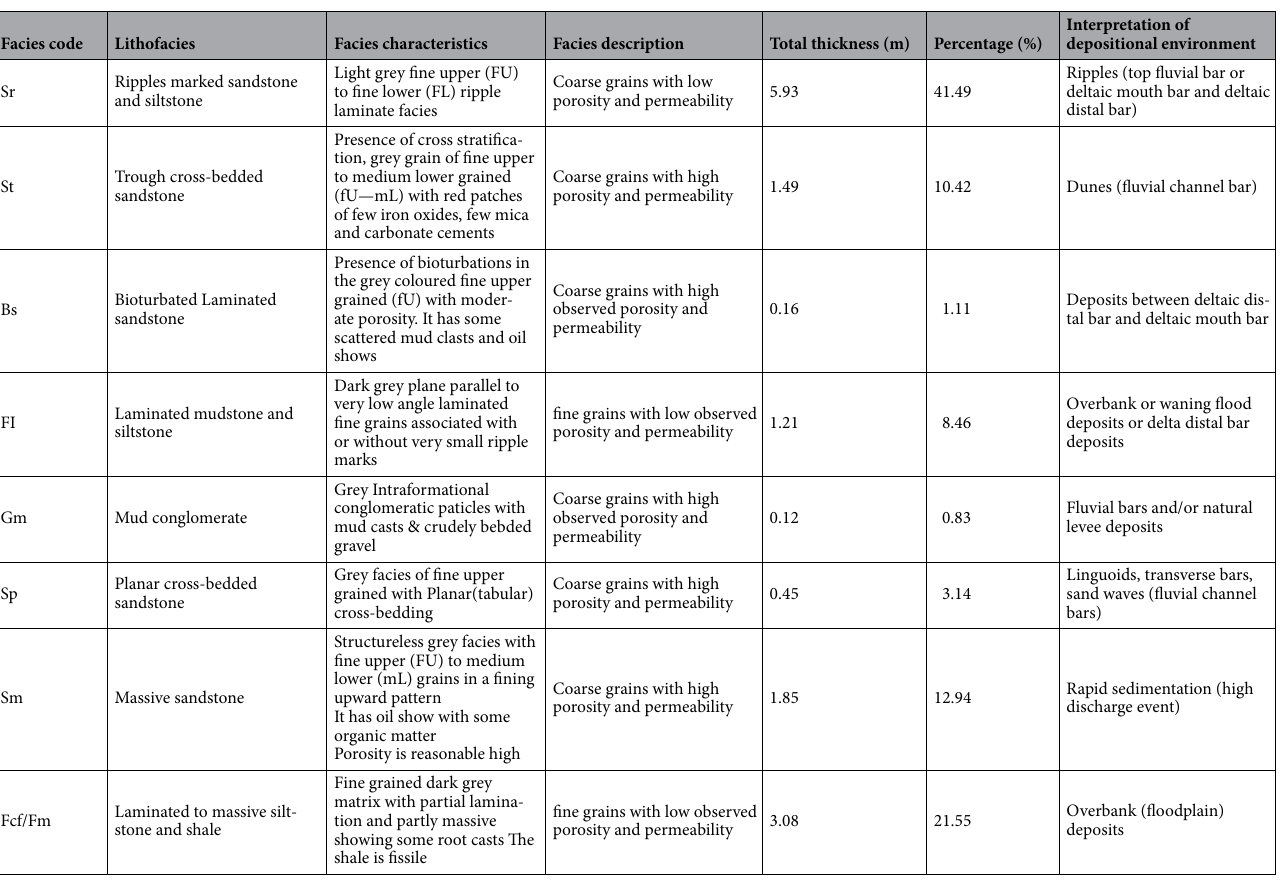
Table 3. Facies parameters and inferred depositional environments of the cores from Keyi N-A well.